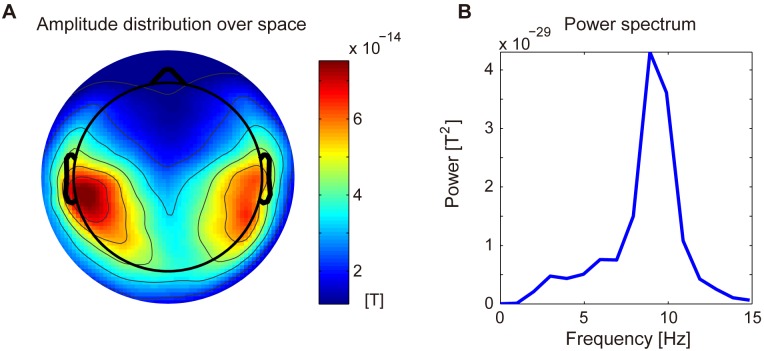
Properties of unlocked waveforms.
A: Amplitude distribution over space of unlocked waveforms. Amplitudes are averaged across subjects. B: Power spectrum of unlocked waveforms. Powers are averaged across sensors and subjects.